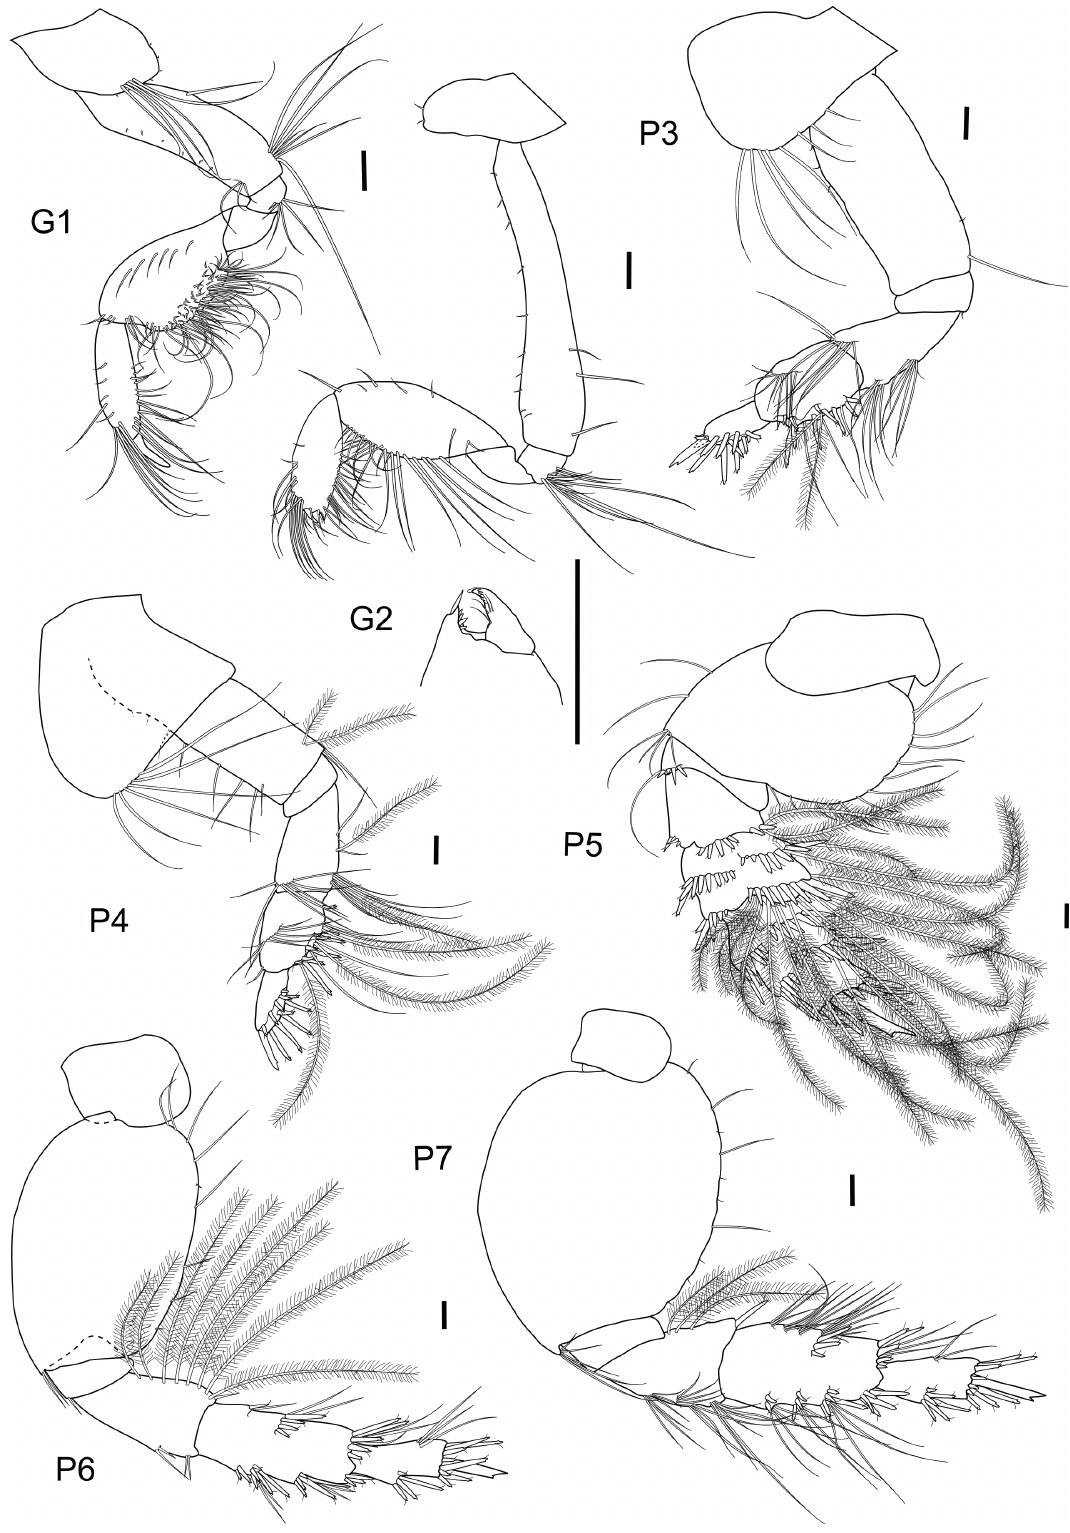
Figure 6 - Puelche irenae sp. nov. Male, 5.3 mm, MNRJ 28808: Gnathopods and pereopods. Scales = 0.1